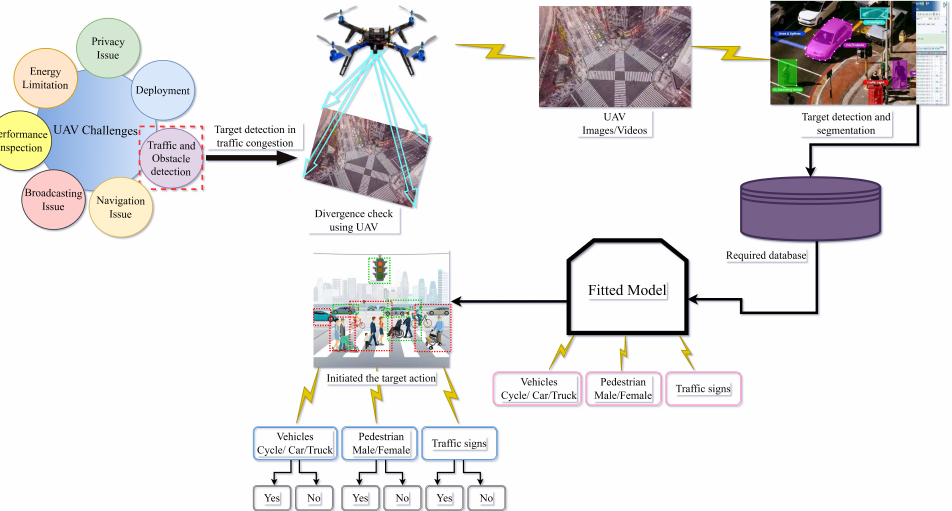
Figure 2. Typical challenges of UAVs with basic framework of target detection in traffic jams through